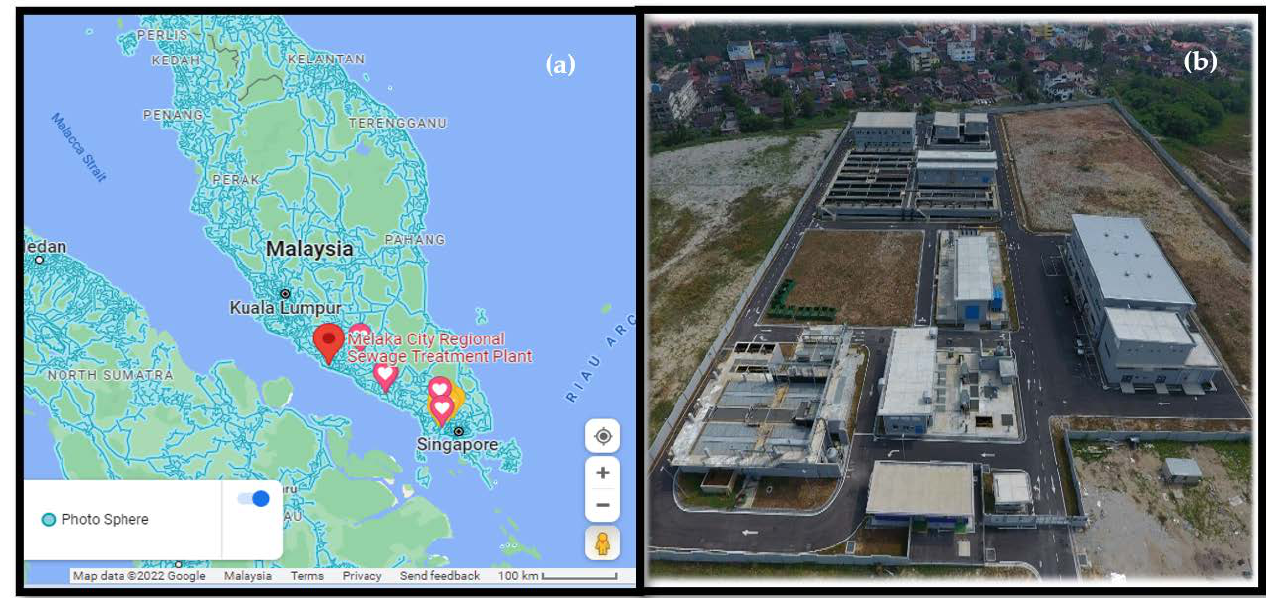
Figure 1. ( a ) Site location with 100 km bar distance and ( b ) layout of centralized sewage treatment plant in Melaka, Malaysia.